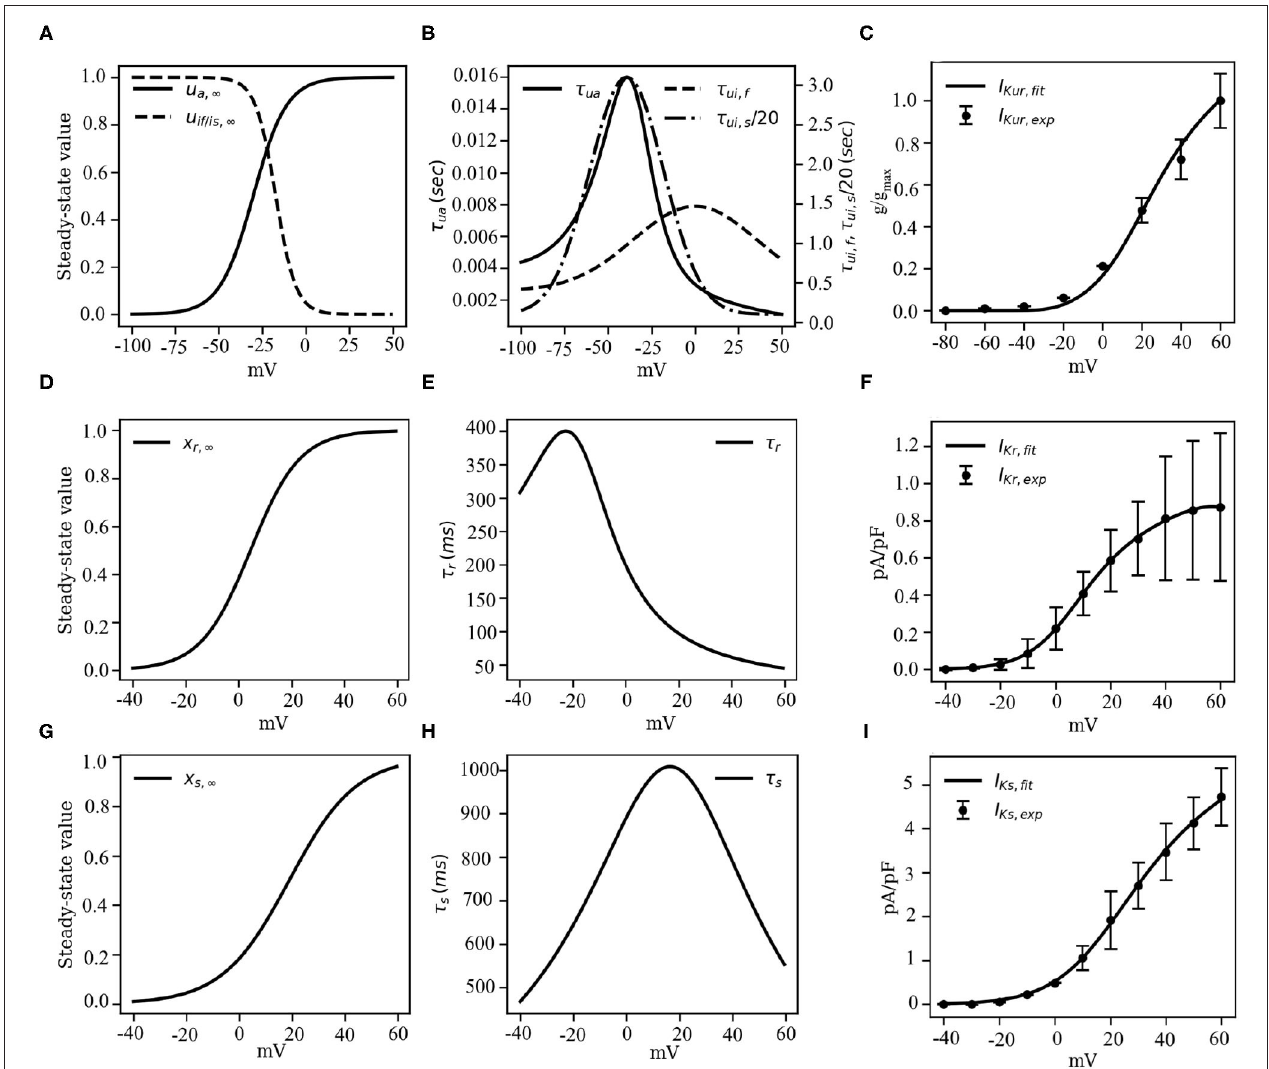
FIGURE 5 | Channel kinetics and current-voltage characteristics of the rectifying K + currents I Kur , I Kr and I Ks . (A) Voltage-dependence of steady-state activation ( u s , ∞ ) and inactivation ( u if , ∞ of u is , ∞ ) probabilities of I Kur . (B) Voltage-dependence of the time constants of activation ( τ ui ) and inactivation ( τ uf or τ us ) of I Kur , reduced by a factor of 20. (C) Comparison between the model-generated IV curve for I Kur and the IV curve reported by Ehrlich et al. (2006) based on experiments. (D) Voltage-dependence of steady-state activation ( x r , ∞ ) probability of I Kr . (E) Voltage-dependence of the time constant of activation ( τ r ) of I Kr . (F) Comparison between the model-generated IV curve for I Kr and the experimentally obtained IV curve from Li et al. (2004). (G) Voltage-dependence of steady-state activation ( x s , ∞ ) probability of I Ks . (H) Voltage-dependence of the time constant of activation ( τ s ) of I Ks . (I) Comparison between the model-generated IV curve for I Ks and the experimentally obtained IV curve from Li et al.